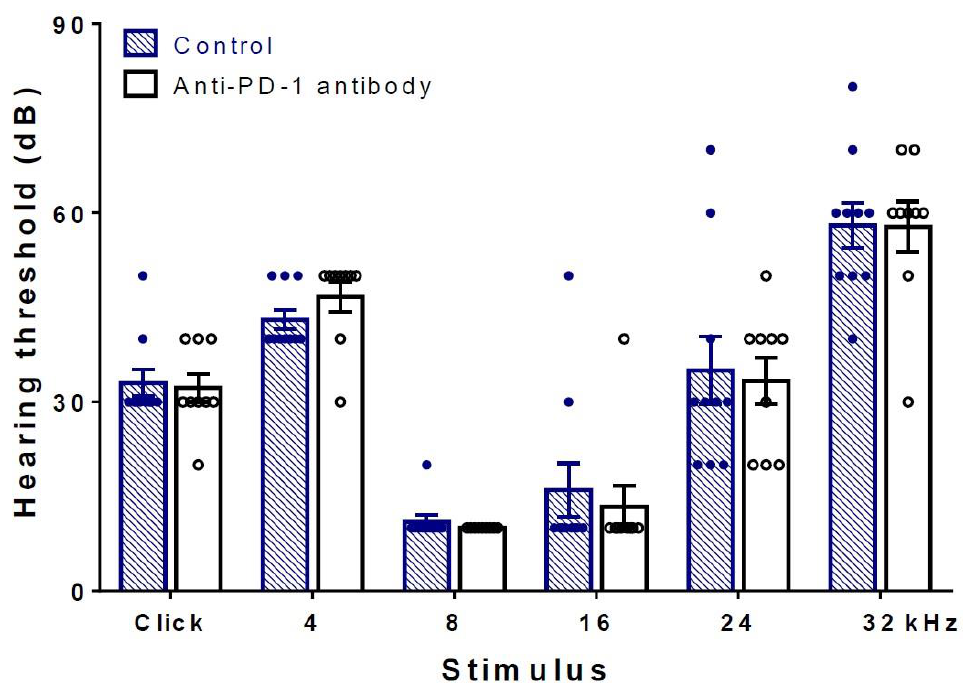
Figure 1. Hearing thresholds of C57BL/6J mice were not influenced by anti-PD-1 antibody